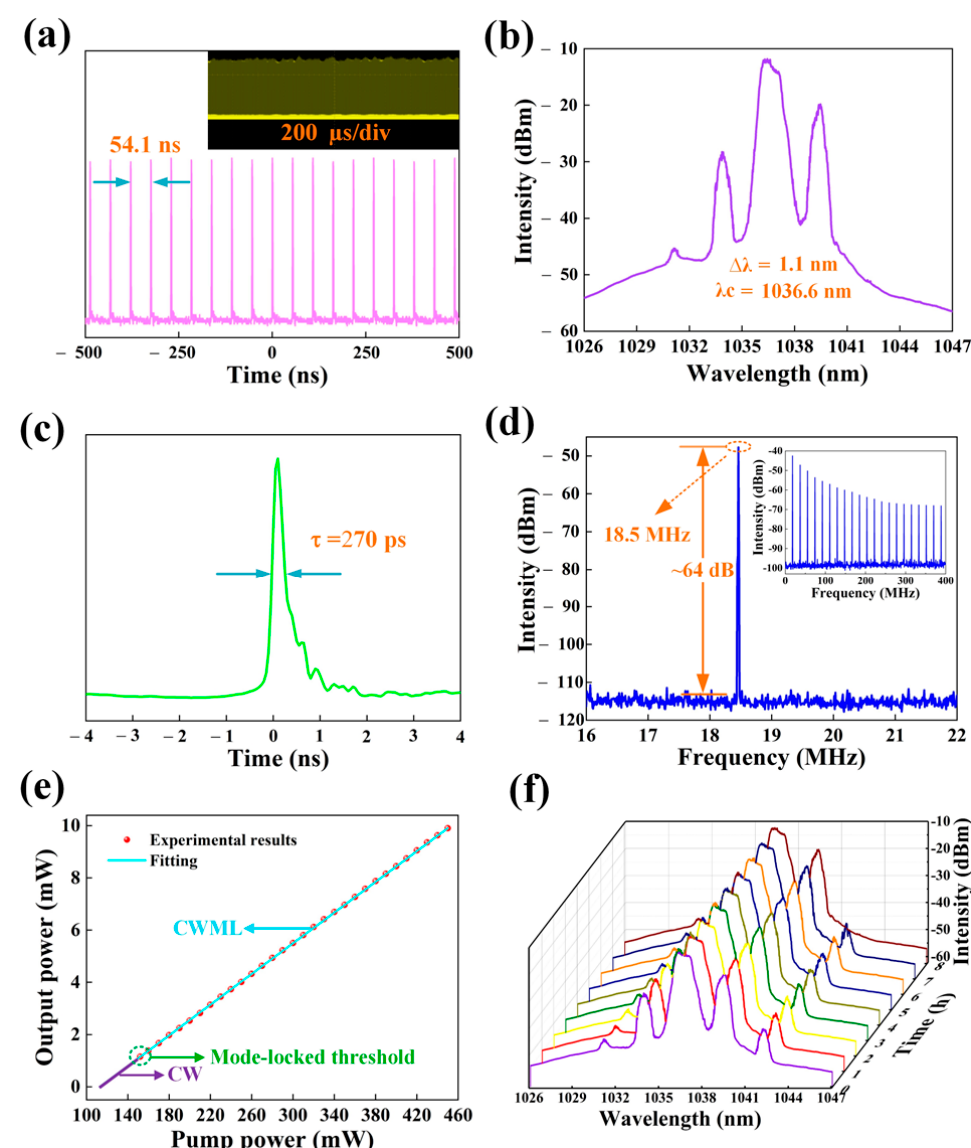
Figure 8. Typical ML YDF pulse characteristics. ( a ) Pulse train. ( b ) Optical spectrum. ( c ) Measure- ment of the laser pulse width. ( d ) RF spectrum (inset: wideband RF spectrum) of the ML pulses. ( e ) Variation in the output power with the pump power. ( f ) Optical spectra measurements at 1 h inter- vals over 8 h.